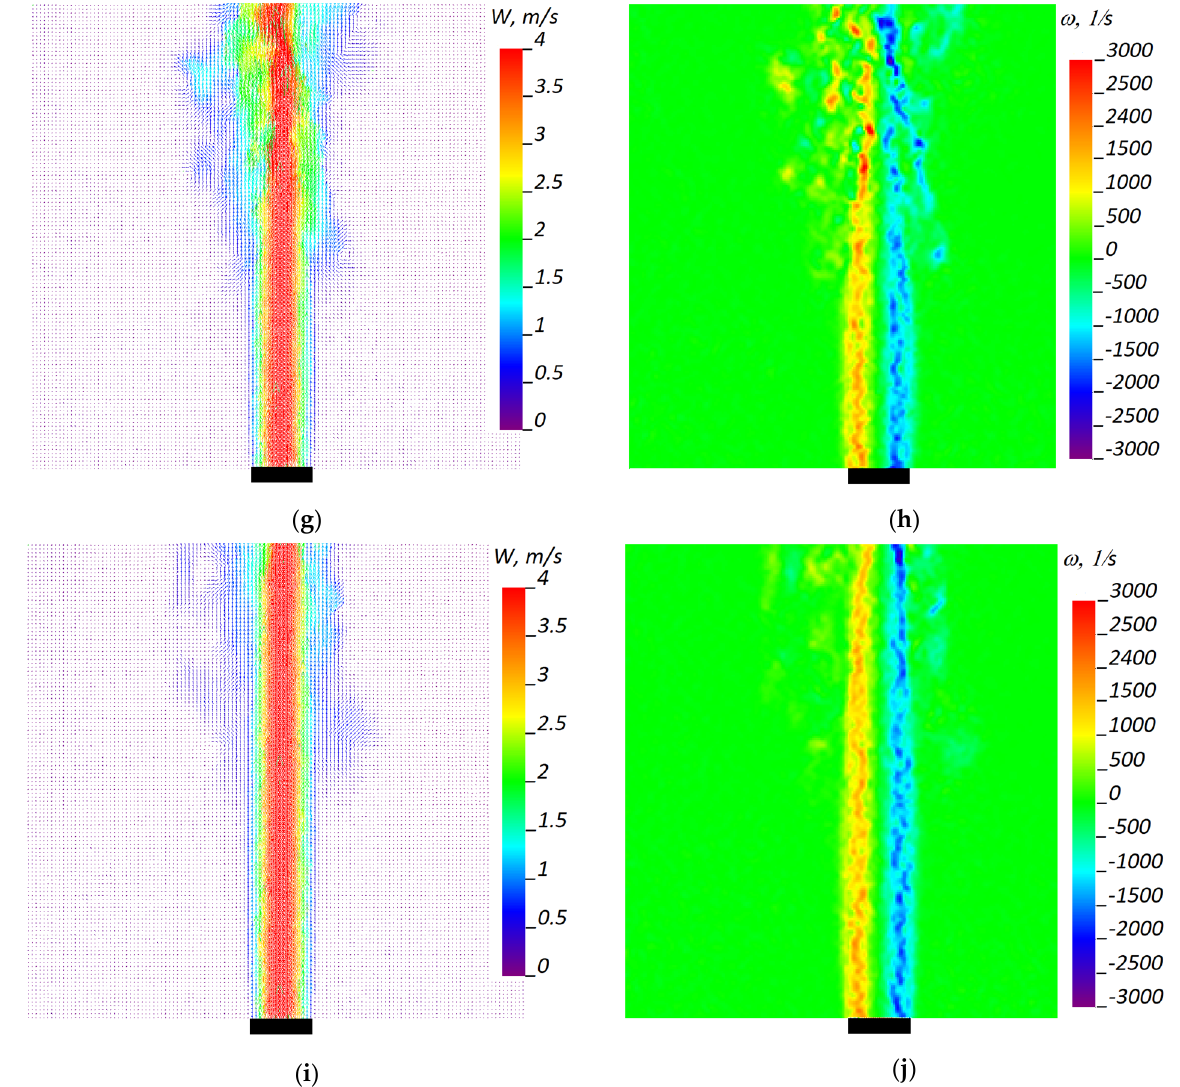
Figure 6. Instantaneous velocity ( a , c , e , g , i ) and vorticity ( b , d , f , h , j ) fields during puff propagation. The fields correspond to the time instants in the time series in Figure 5: ( a , b ) t 1 = 0.65 s; ( c , d ) t 2 = 0.69 s; ( e , f ) t 3 = 0.7 s; ( g , h ) t 4 = 0.72 s; ( i , j ) t 5 = 0.74 s.